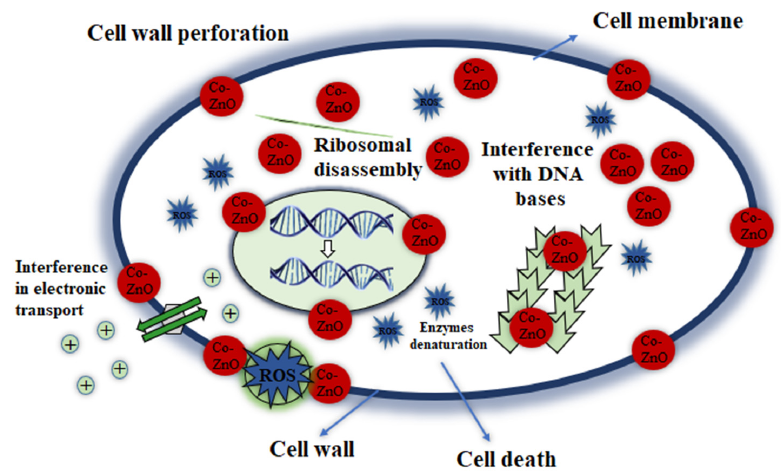
Figure 8. Schematic illustration for antimicrobial mechanism of Co-doped ZnO microcrystals against microbial strains.